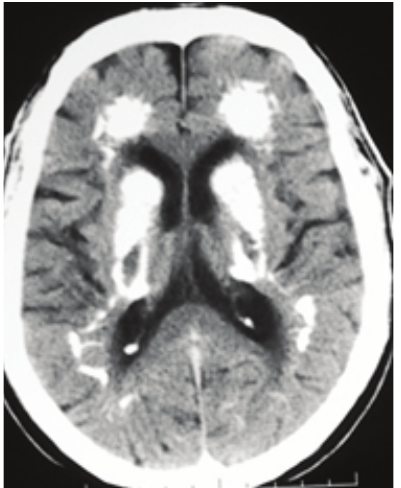
Figure 1: CT scan axial view demonstrating extensive bilateral calcifications in the periventricular white matter (frontal horns, basal ganglia, and internal capsule).